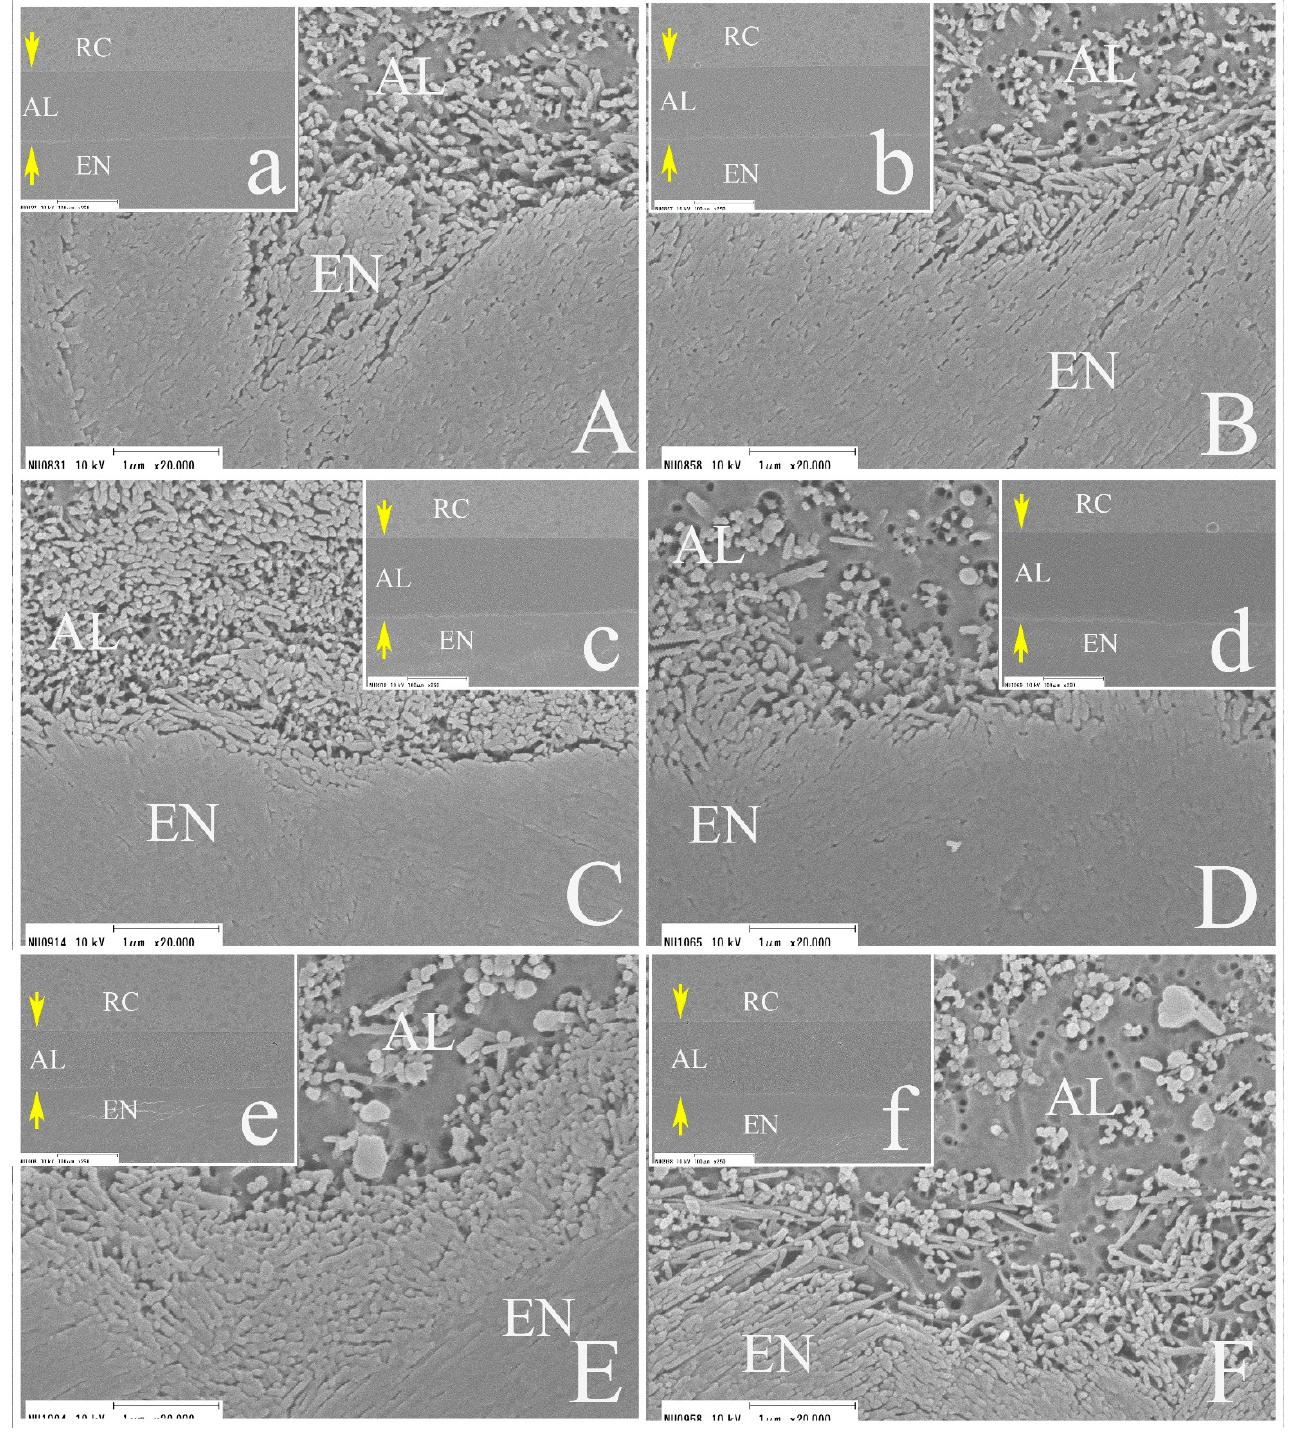
Figure 9. Representative SEM images of resin/enamel interfaces (Group III). ( A ) CS in SE mode (×20,000, ×1000). ( B ) CS in ER mode (×20,000, ×1000). ( C ) GU in SE mode (×20,000, ×1000). ( D ) GU in ER mode (×20,000, ×1000). ( E ) OX in SE mode (×20,000, ×1000). ( F ) OX in ER mode (×20,000, ×1000). AL: adhesive layer, EN: enamel, RC: resin composite. The yellow arrows indicate the adhesive layer.